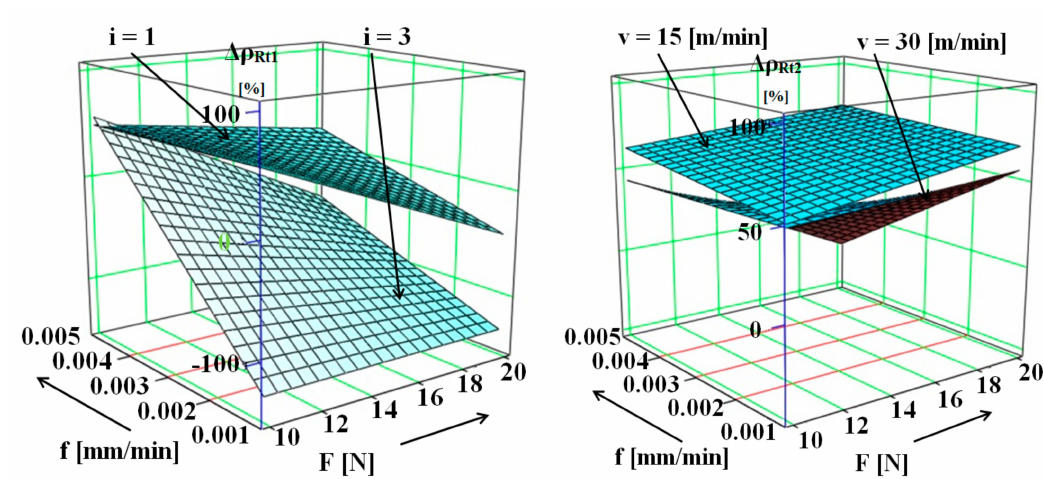
Figure 6. Changes in R t for Experiment I ( left ) and Experiment II ( right